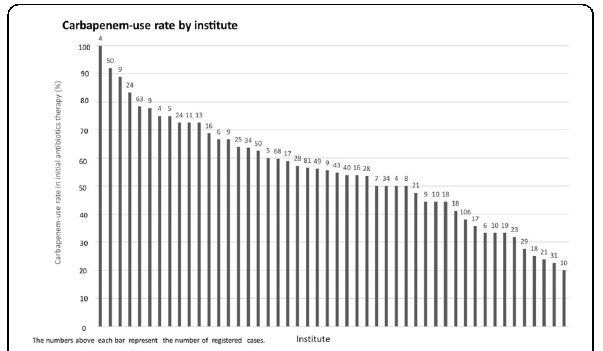
Fig. 1 (abstract 001032). Carbapenem-use rate by